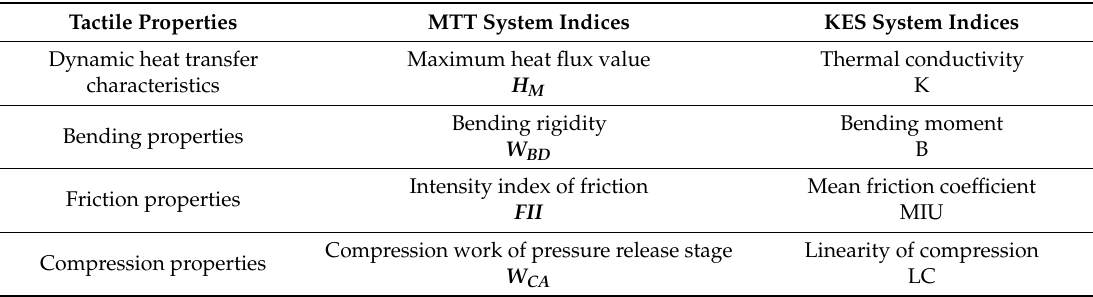
Table 3. Objective indices of tactile properties for correlation analysis between MTT system and KES